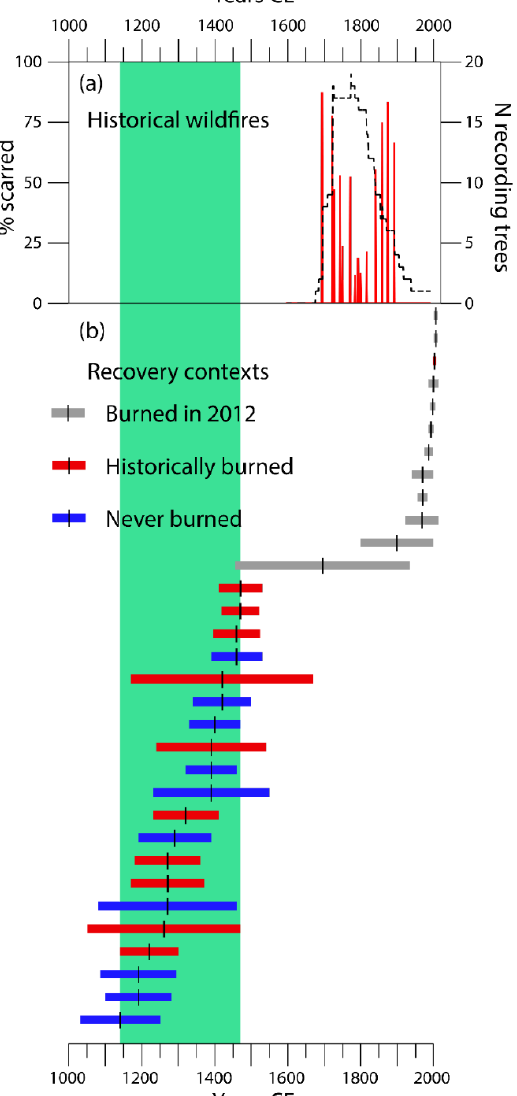
Figure 3. Optically stimulated luminescence (OSL) age estimates and fire-scar dated fire activity at Wabakwa. ( a ) Synchrony plot (% of trees recording a fire in a given year, red lines) with sample depth of recording trees (dashed line). Fourteen replicated historical fires ( ≥ 2 trees recording a fire) were recorded between 1696 and 1893 CE, 8 of these burned between 1724 and 1893 CE within 100 m of the midden sampling location. ( b ) Plot of the mean and 2σ age ranges for OSL measurements of archaeological ceramics. Gray bars are for samples in areas burned in 2012. Red bars are for samples from areas that burned in historical fires. Blue bars are for sherds from contexts that have never